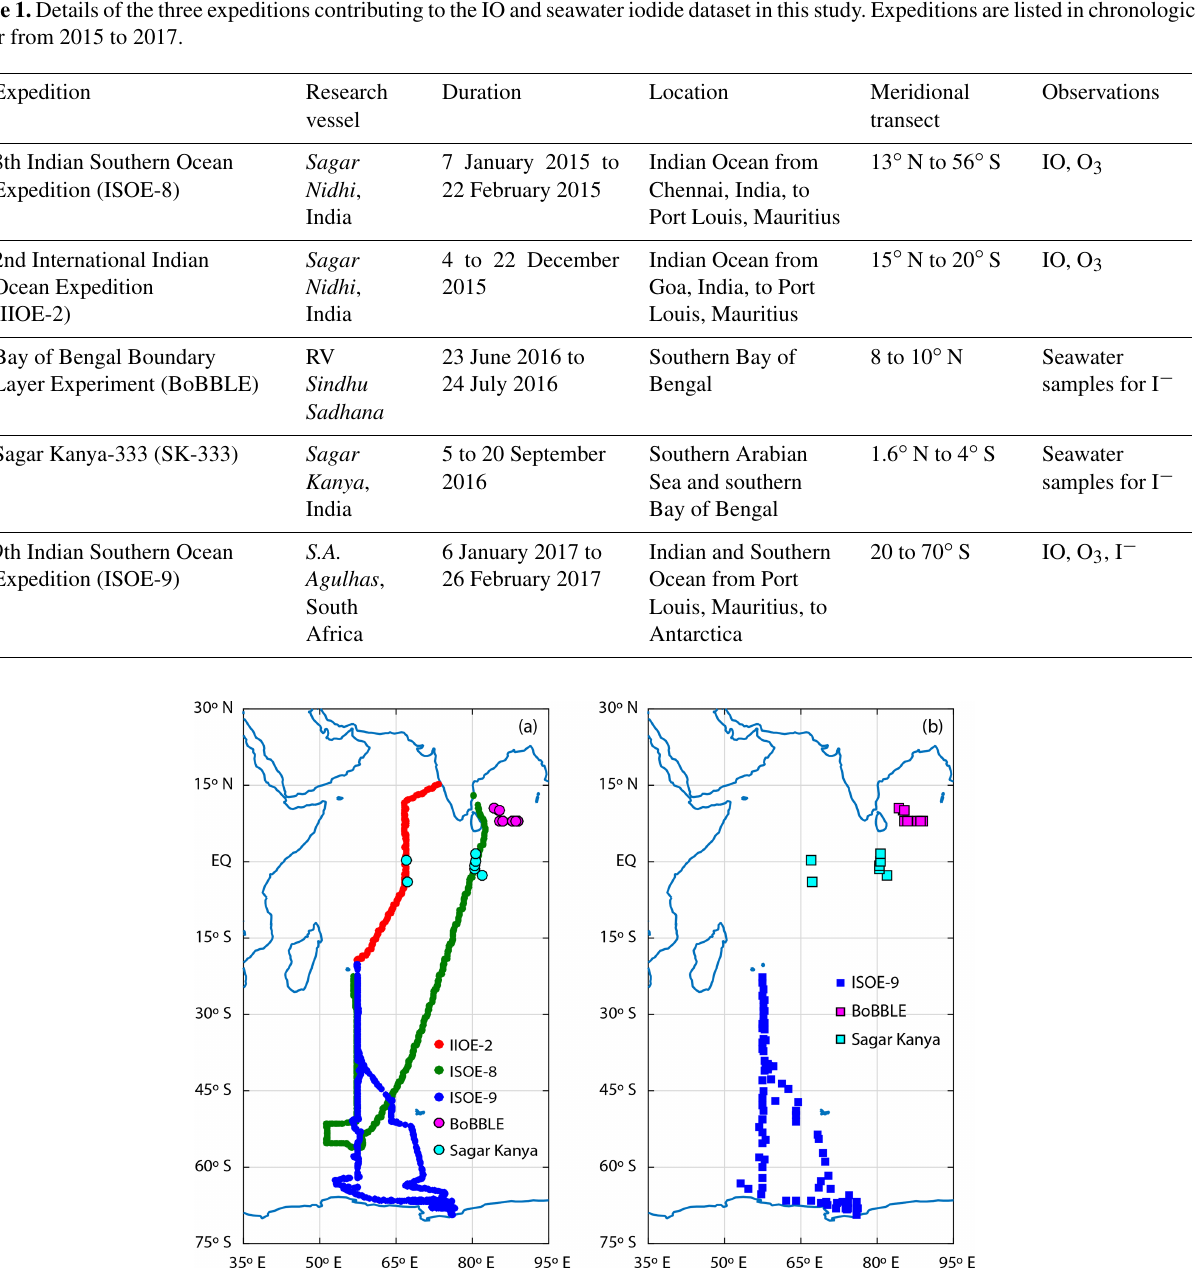
Figure 1. Map of the Indian Ocean and the Southern Ocean (a) with cruise tracks for campaigns conducted during the austral summer of 2014–2016. Green circles indicate the cruise track for ISOE-8, red circles show the cruise track for IIOE-2, and blue circles indicate the cruise track for ISOE-9. Magenta and cyan circles indicate sample locations for the BoBBLE and SK-333 expeditions, respectively. (b) Boxes represent 129 seawater iodide sampling locations from three expeditions following the colour code in (a)